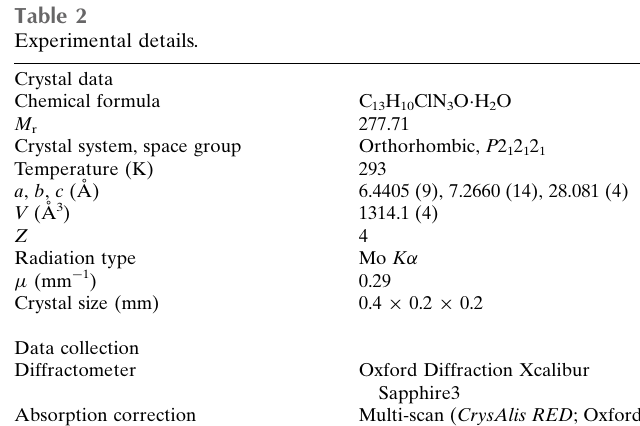
Table 2 Experimental details.